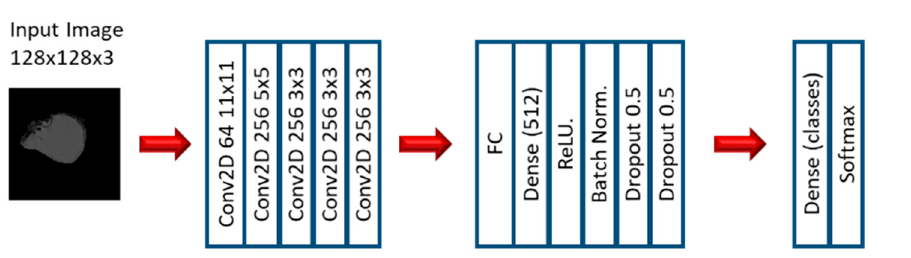
Figure 4. Architecture 4 of CNN base models.